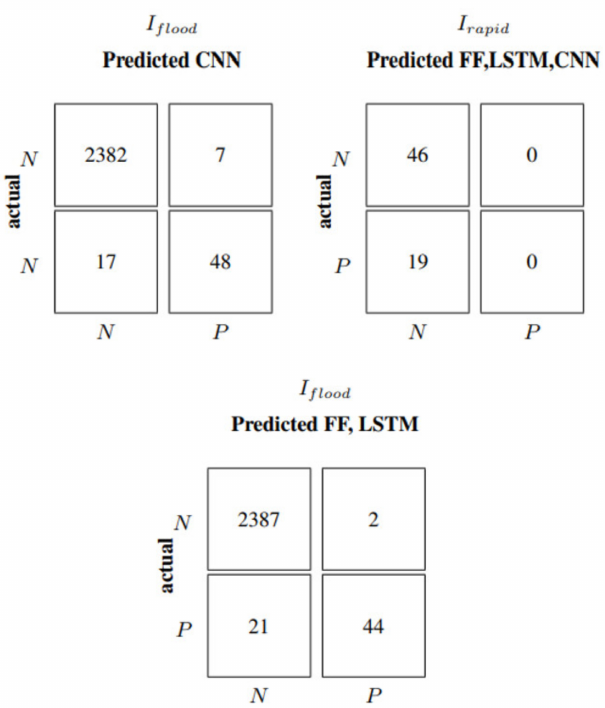
Figure 6. I flood and I rapid for autoregressive FF, LSTM, and CNN models. Test data, Lura River. P means a flood or a rapid event is present, N means that it is